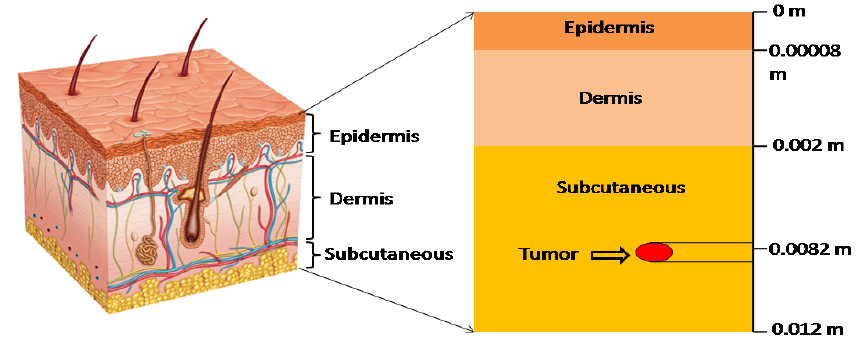
Figure 1. Multilayer skin tissue